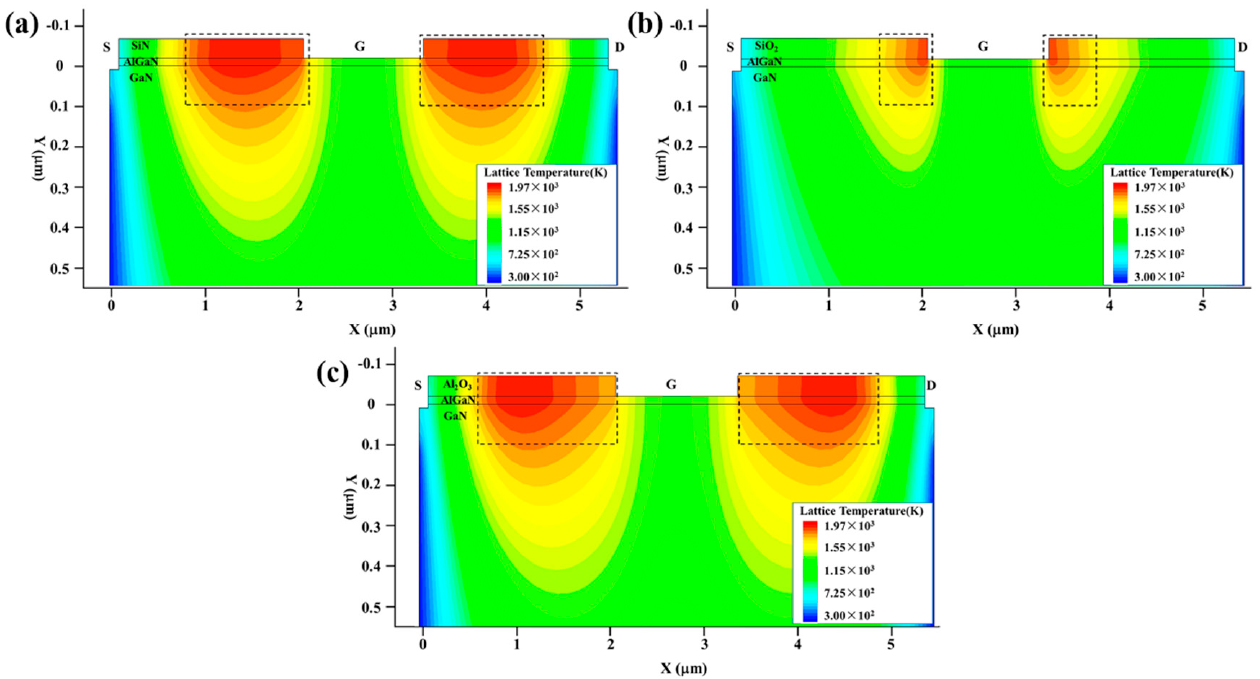
Figure 13. The thermal distribution of the GaN HEMT at the moment of burnout with different passivation layers: ( a ) SiN; ( b ) SiO 2 ; ( c ) Al 2 O 3 .